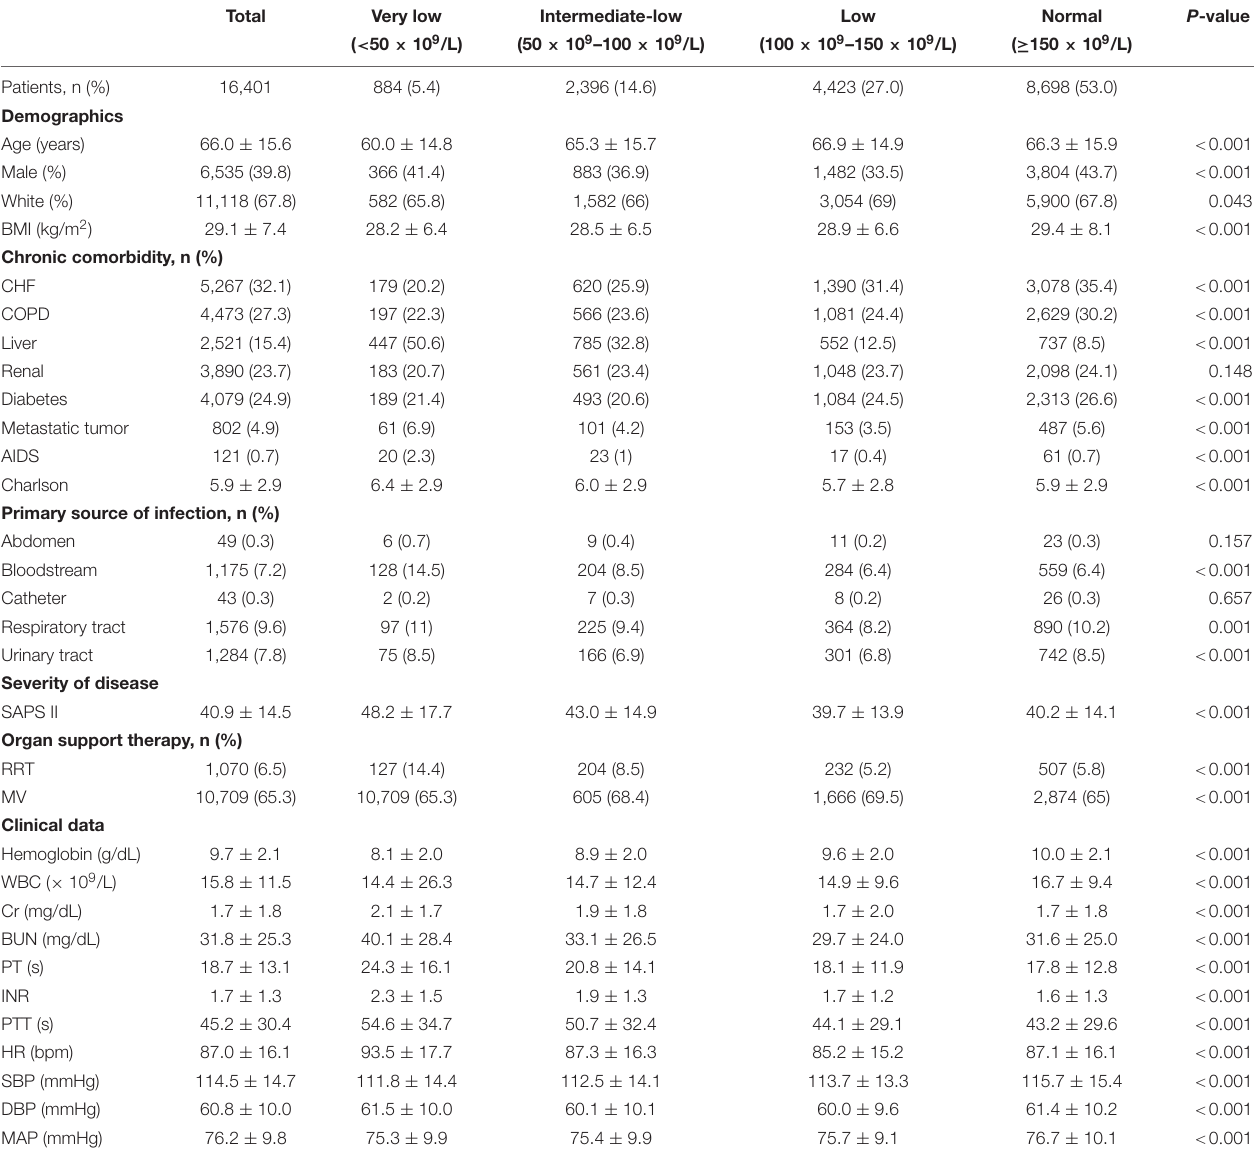
TABLE 1 | Baseline and clinical characteristics of the study population according to platelet count. Total Very low Intermediate-low Low Normal P -value (50 × 10 9 –100 × 10 9 /L) (100 × 10 9 –150 × 10 9 /L)